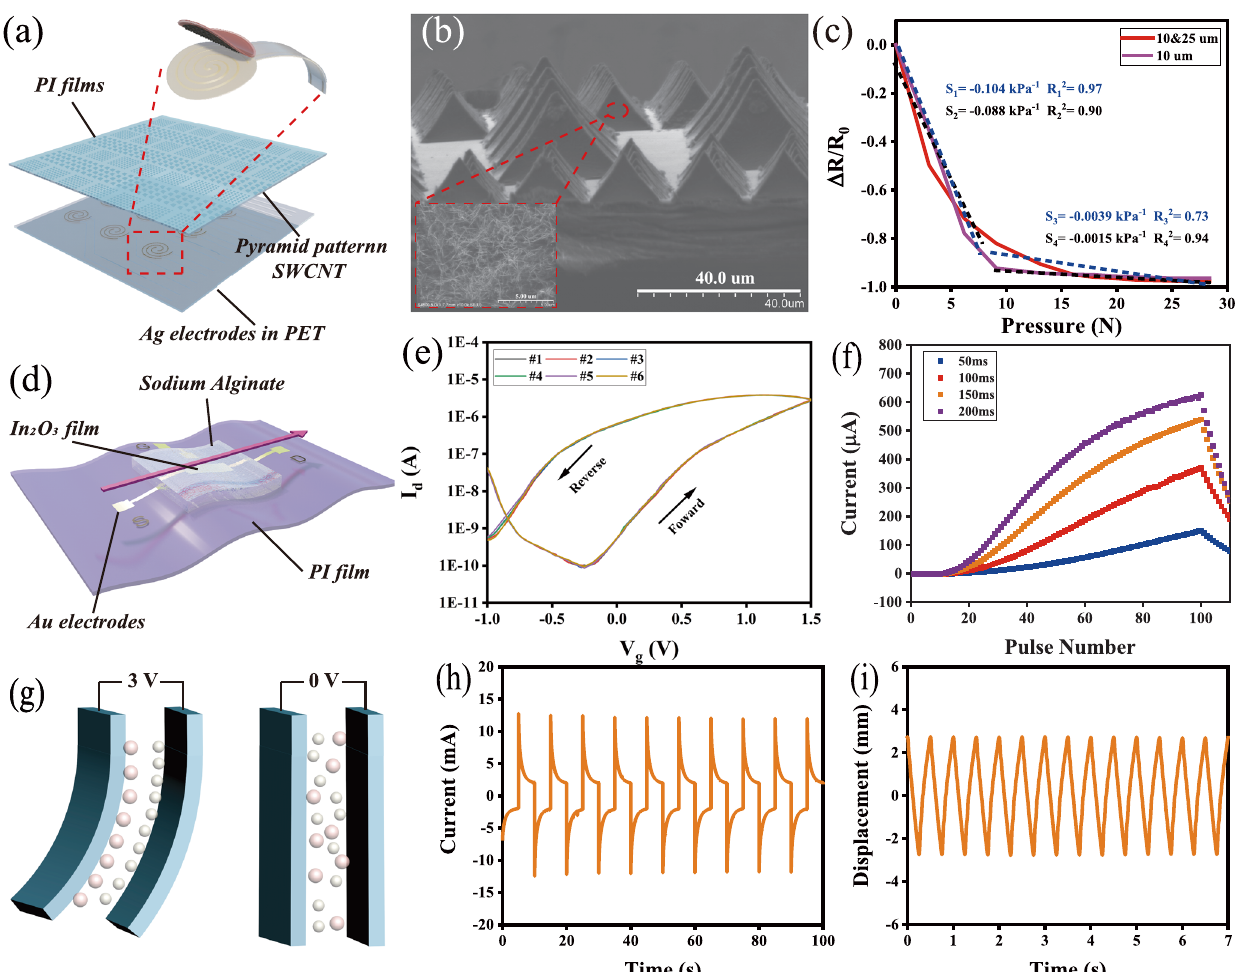
Fig. 2 The main components of the arti fi cial somatosensory system. a The schematic diagram and the structure of the CNT/PI based fl exible sensor with pyramidal microstructure. b SEM images of the CNT/PI fi lm in the fl exible sensor, indicating that the fi lm with multiple different sizes of micro pyramid structures with carbon nanotube networks. c Response of the resistance variation of the fl exible tactile sensor under pressures from 0 to 30 N that with different micro pyramid structures (purple curve and blue curves represent the single and multiple different sizes of micro pyramid structure, respectively. The Fitted curves (dotted blue and black lines) show the sensitivity of the device. d The schematic diagram of the In 2 O 3 /SA-based arti fi cial synaptic transistor. e Transfer characteristics of the arti fi cial synaptic transistor at V ds of 0.5 V. f The EPSC triggered by presynaptic spikes with different voltage pulses. g Schematic con fi guration of the IPMC actuator. h The current response of the IPMC actuator at an applied square wave voltage (±2.5 V, 0.1 Hz). i Bending responses of the IPMC actuator at an applied square wave voltage (±2.5 V, 2